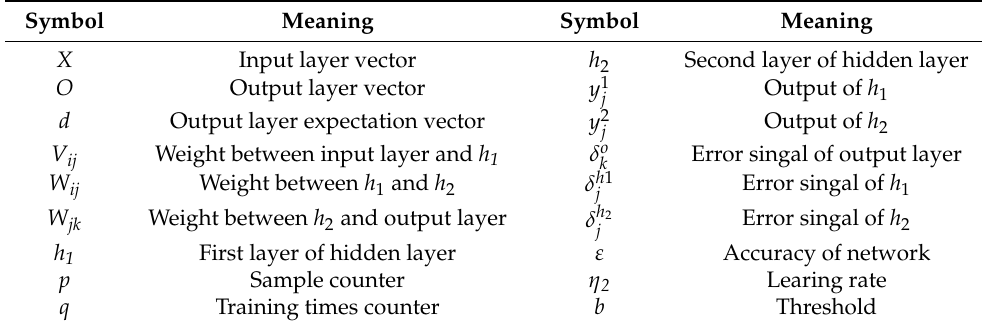
Table 2. Meaning of symbols.